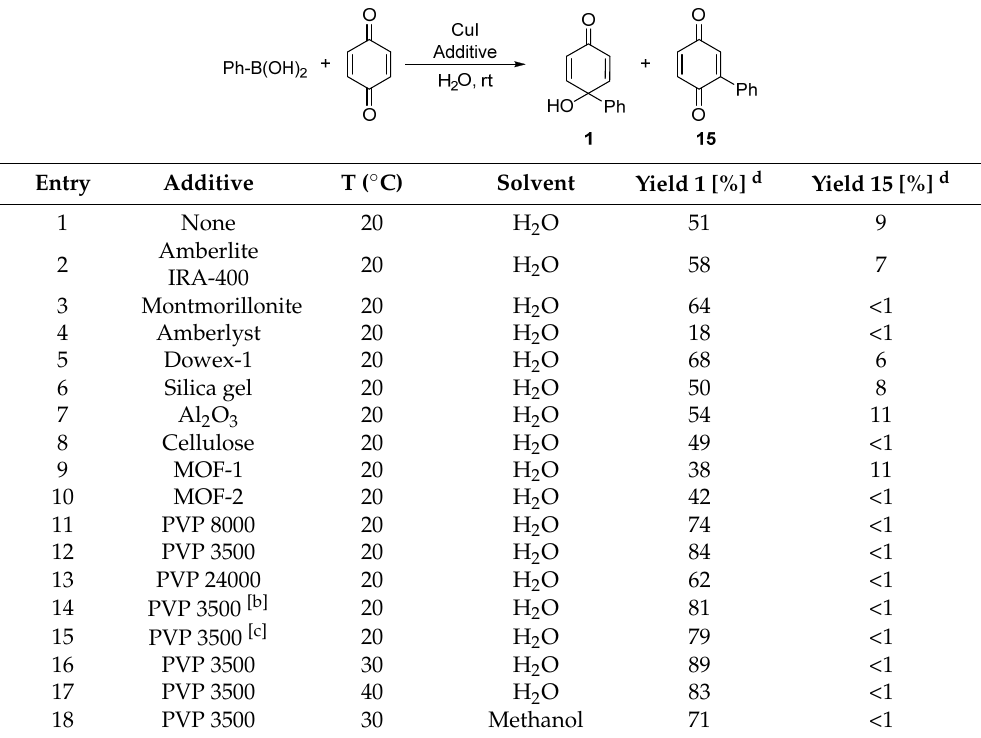
Table 1. Model copper catalyzed 1,2-addition of phenylboronic acid to 1,4-benzoquinone. a Optimization studies.